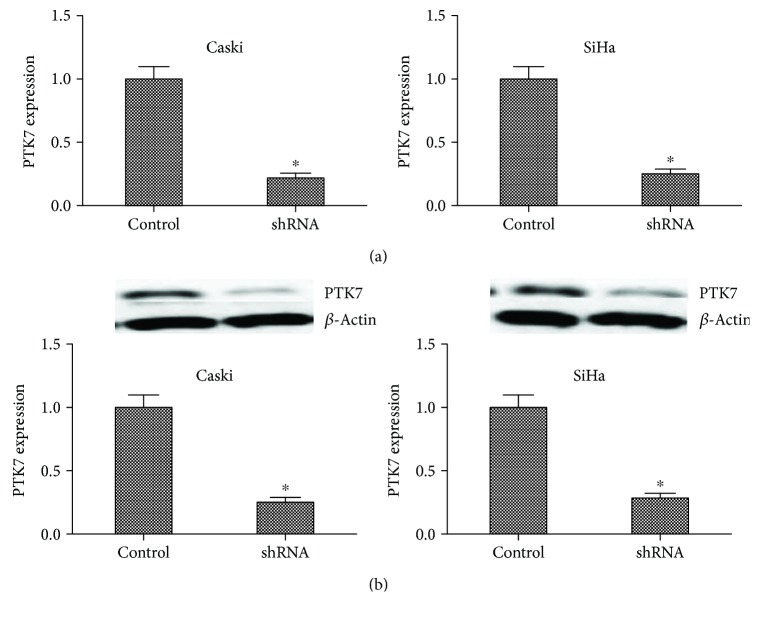
Establishing the stable knockdown of PTK7 cell lines: (a, b) qRT-PCR and Western blot assay. PTK7 mRNA and protein levels were significantly decreased compared to the control. (∗P < 0.05).